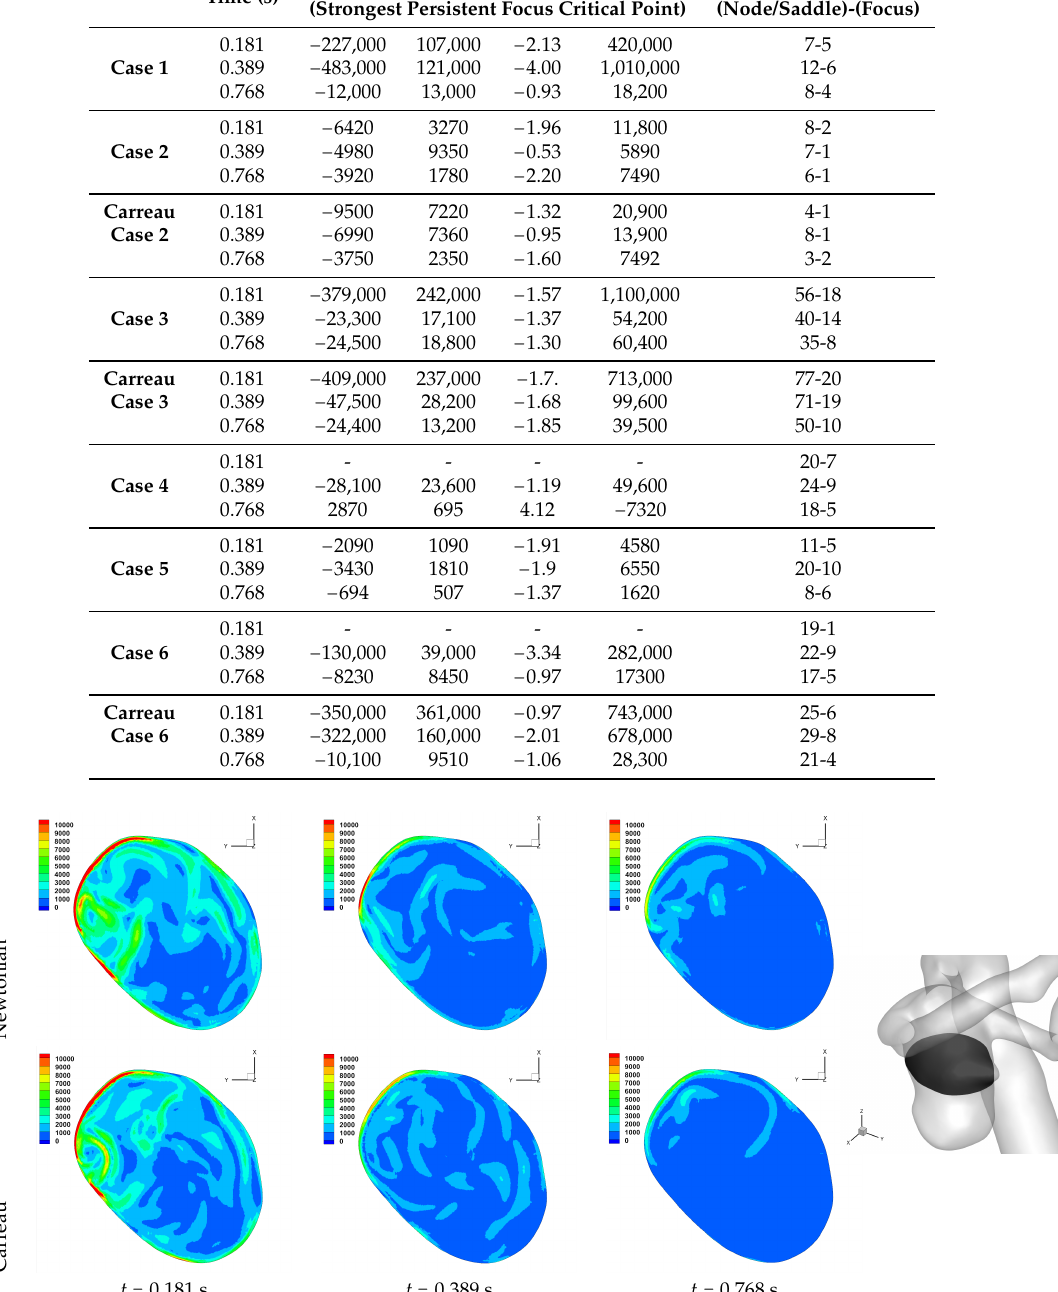
Figure 10. Cross-section plots of shear rate magnitude ˙ γ (s − 1 ) of Case 3, for Newtonian and Carreau rheological models. Location of the cross-section is